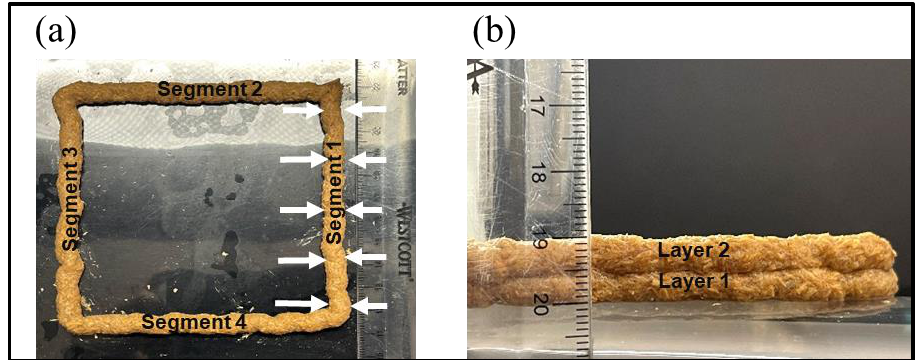
Figure 7. Printed samples for measurements of print quality: ( a ) one layer and ( b ) two layers.